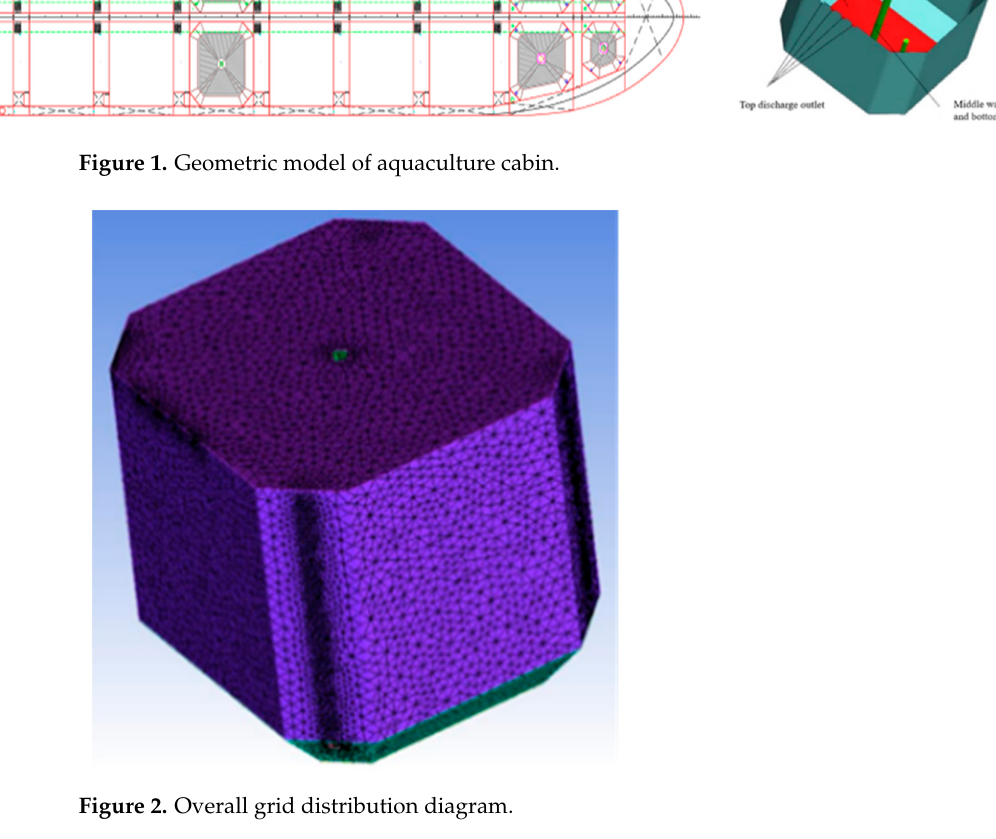
Figure 2. Overall grid distribution diagram.